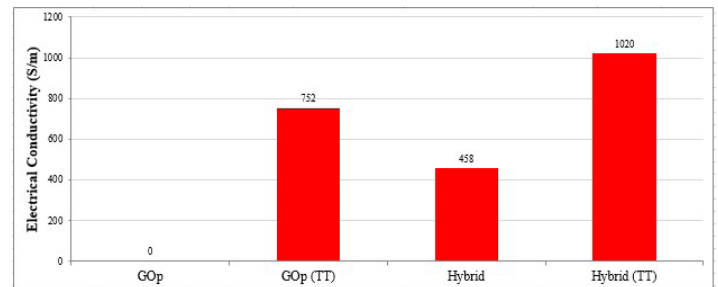
Figure 9. Electrical conductivity of the pure GO and hybrid paper-likes untreated and treated thermally